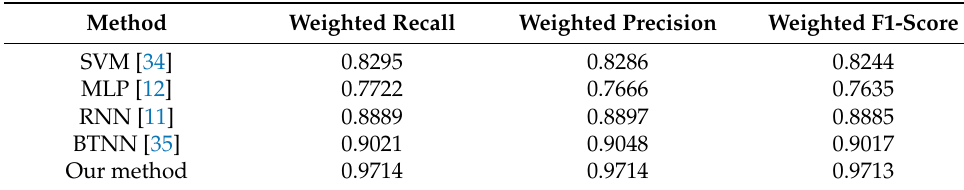
Table 1. Results of contrast